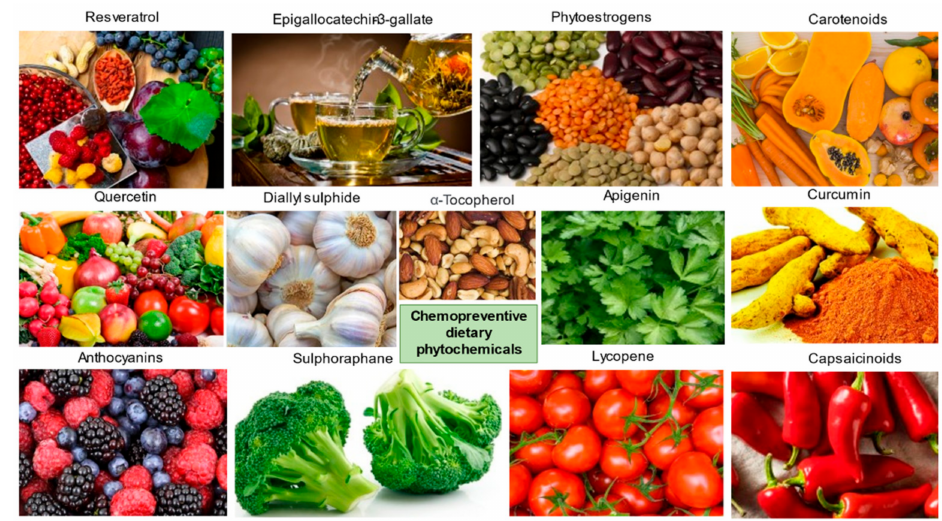
Figure 2. Common examples of chemopreventive dietary phytochemicals.